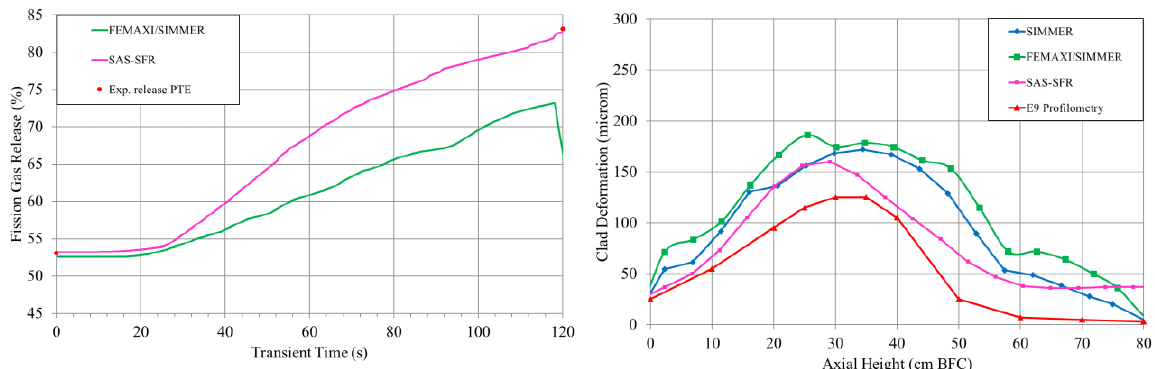
Figure 3. Fission gas release Figure 4. Cold cladding radial